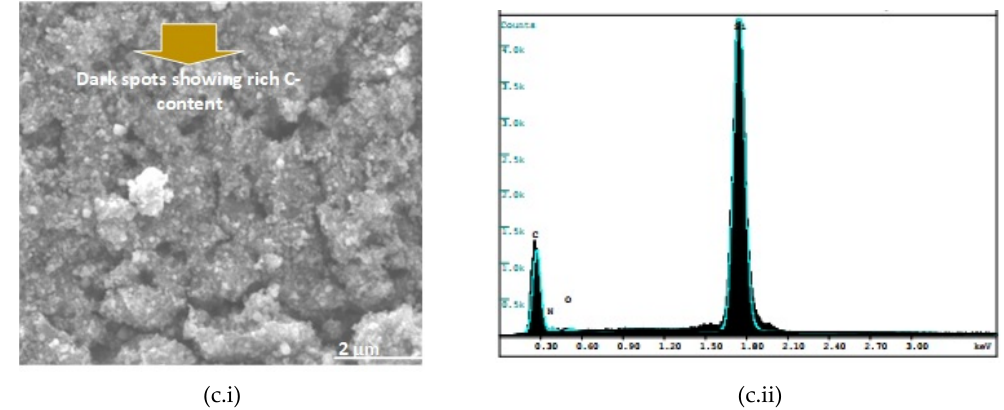
Figure 4. SEM images and EDS spectra showing the morphologies and energy peaks corresponding to the various elements respectively, of the pelletized C/SiCN nanocomposites pyrolyzed and heat treated between 1100–1600°C in an argon atmosphere: ( a.i ) SEM images of the samples pyrolyzed at 1100°C; ( a.ii ) EDS spectrum of the sample pyrolyzed at 1100°C; ( b.i ) SEM images of the samples heat treated at 1400°C; ( b.ii ) EDS spectrum of the sample heat treated at 1400°C; ( c.i ) SEM images of the samples heat treated at 1600°C; ( c.ii ) EDS spectrum of the sample heat treated at 1600°C. Table 2. The chemical composition of the C/SiCN nanocomposites after pyrolysis. Elemental Composition (wt. %) Pyrolysis N/Si (at. Temperature